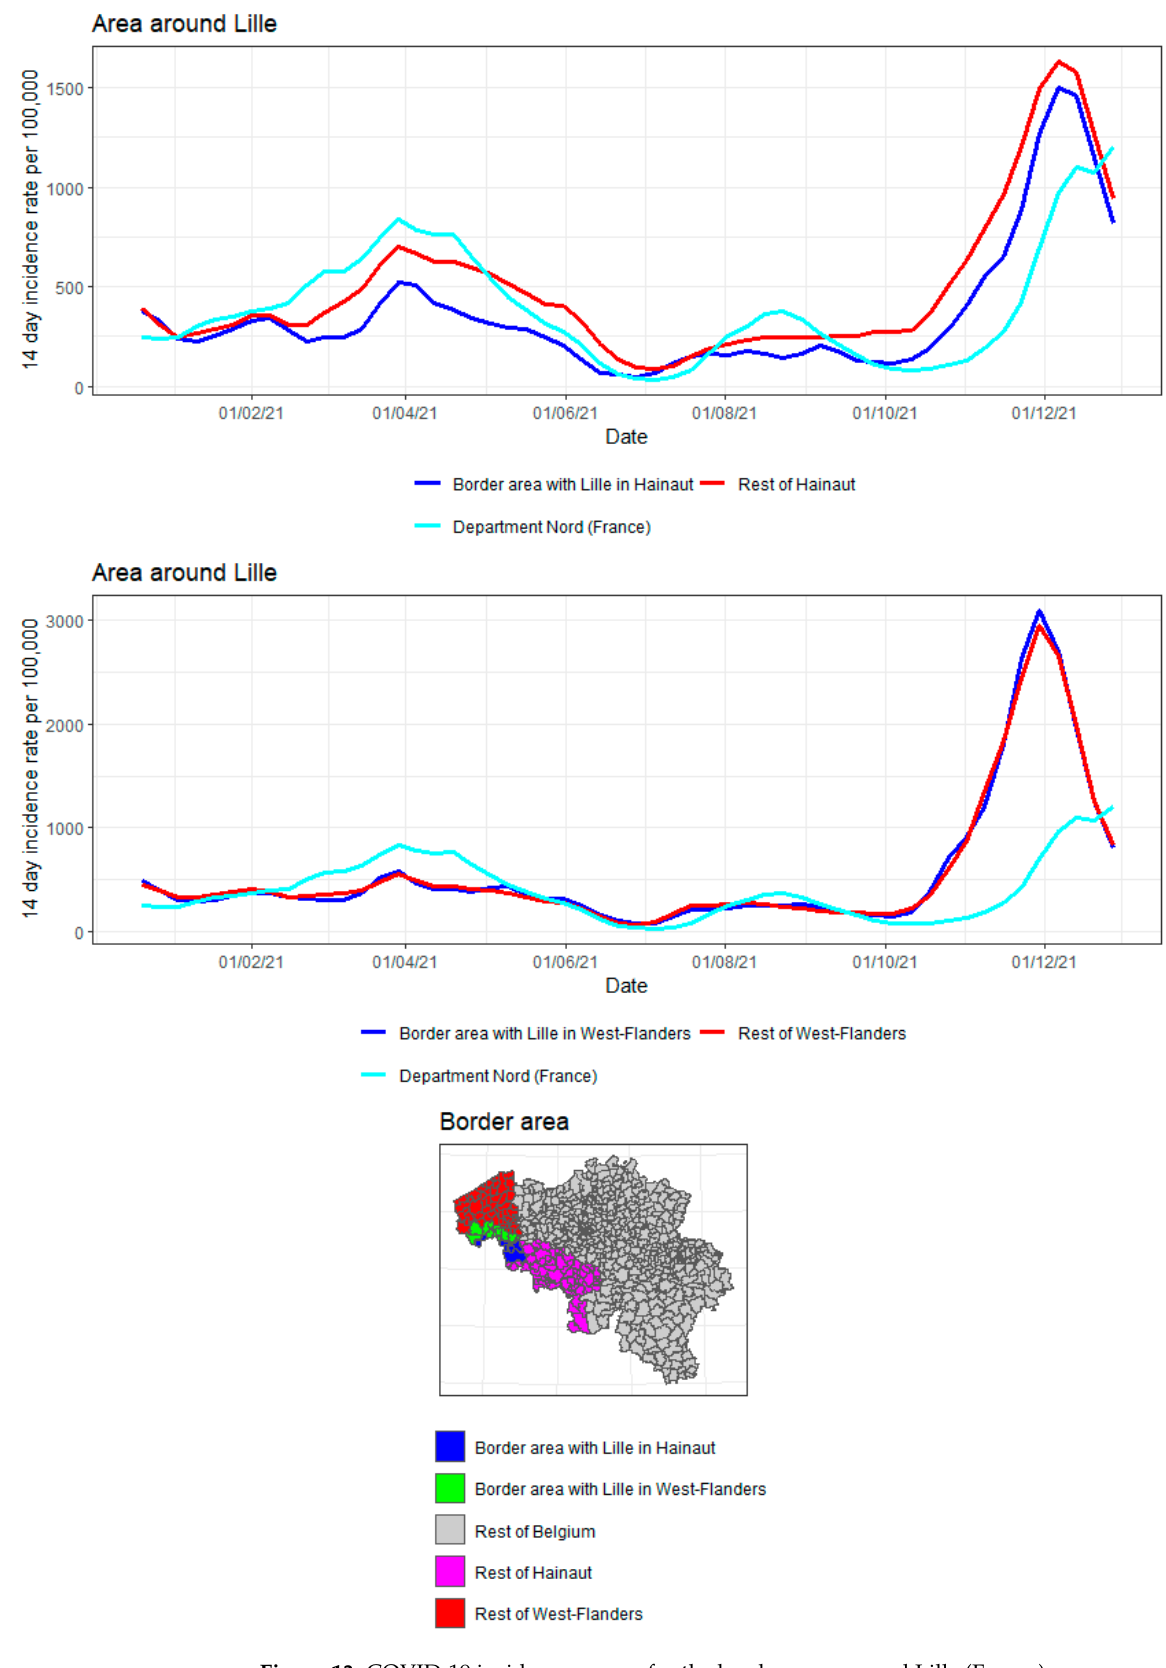
Figure 13. COVID-19 incidence curves for the border area around Lille (France).